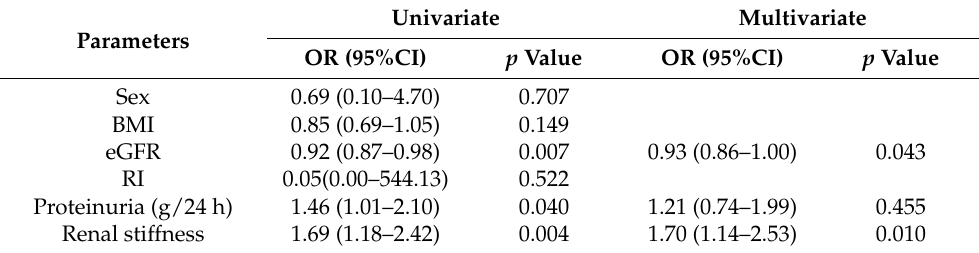
Table 5. Results of logistic regression analysis on moderate-to-severe IF/TA (grade ≥ 2).